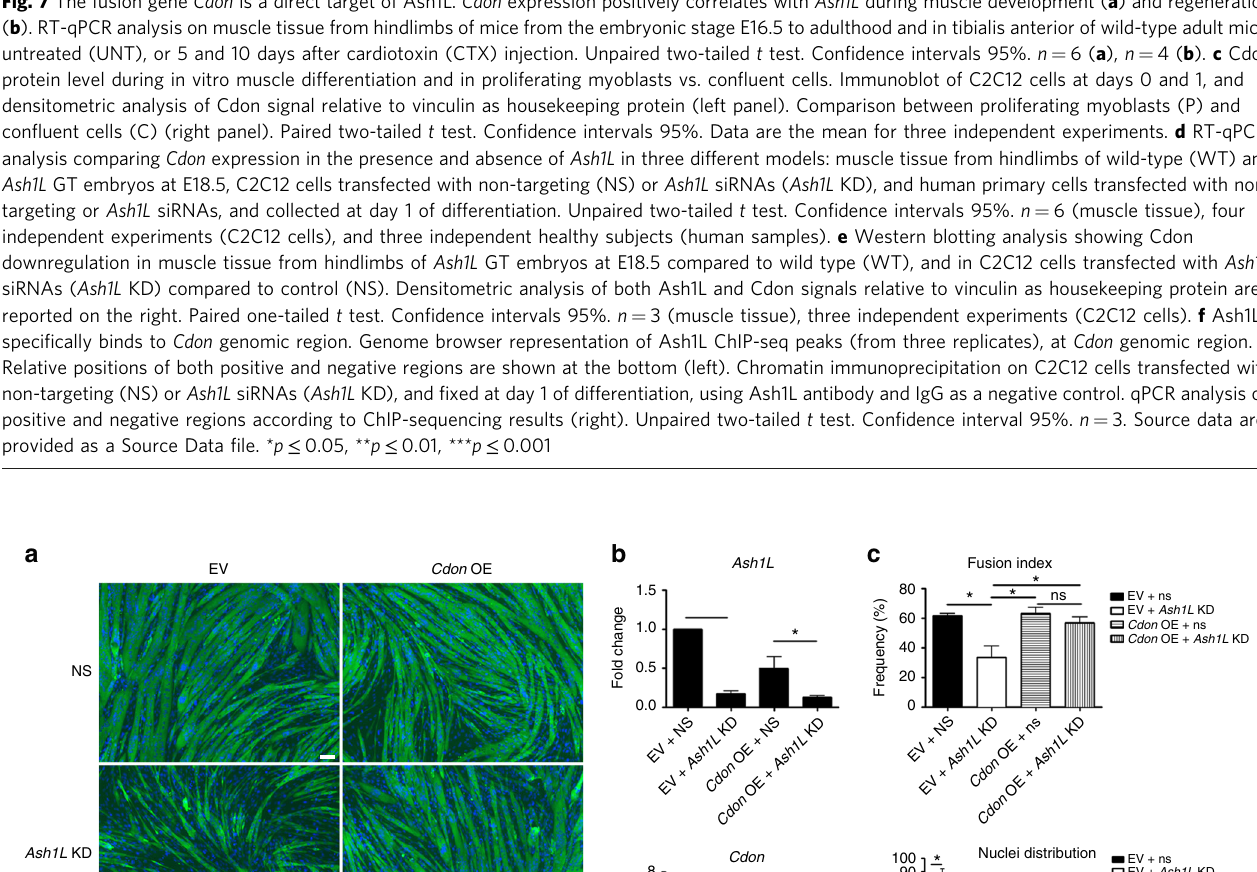
Fig. 8 Cdon expression rescues fusion defects caused by Ash1L knockdown. a Immuno fl uorescence for myosin heavy chain and nuclear staining in C2C12 cells treated with two consecutive rounds of transient transfections: non-targeting (NS) or Ash1L siRNAs ( Ash1L KD), and empty vector (EV) or Cdon- expressing vector ( Cdon OE), before inducing differentiation for 3 days (left). Scale bar, 100 µ m. b RT-qPCR analysis of Ash1L and Cdon expression in C2C12 cells transfected with: empty vector plus non-targeting siRNAs (EV + NS), empty vector plus Ash1L siRNAs (EV + Ash1L KD), Cdon- expressing vector plus non-targeting siRNAs ( Cdon OE + NS), and Cdon- expressing vector + Ash1L siRNAs ( Cdon OE + Ash1L KD). c Fusion index and nuclei distribution for each condition were calculated as described for Fig. 3. Unpaired two-tailed t test. Con fi dence intervals 95%. n = 3. Source data are provided as a Source Data fi le. * p ≤ 0.05, ** p ≤ 0.01, *** p ≤ 0.001. NS not signi fi N-cadherin, neogenin, Hedgehog, and Wnt pathways 21 . Cdon is a Polycomb target (Supplementary Data 5), is upregulated during muscle differentiation 70 and is the only direct Ash1L target gene with a known role in myoblast fusion 68 . We found that Cdon parallels Ash1L expression during muscle development and regeneration. Moreover, Cdon is signi fi cantly downregulated in muscles of Ash1L GT mice and upon Ash1L depletion in mouse and human muscle cells. Cdon -KO mice display smaller muscle fi bers 68 , as we observed in Ash1L GT mice. Furthermore, primary myoblasts isolated from both Cdon 68 and Ash1L GT mice display a myoblast fusion defect. Importantly, we found that Cdon expression is suf fi cient to rescue the myoblast fusion defect of Ash1L -KD cells indicating that (at least in vitro) Cdon is a key target through which Ash1L regulates myoblast fusion. Future